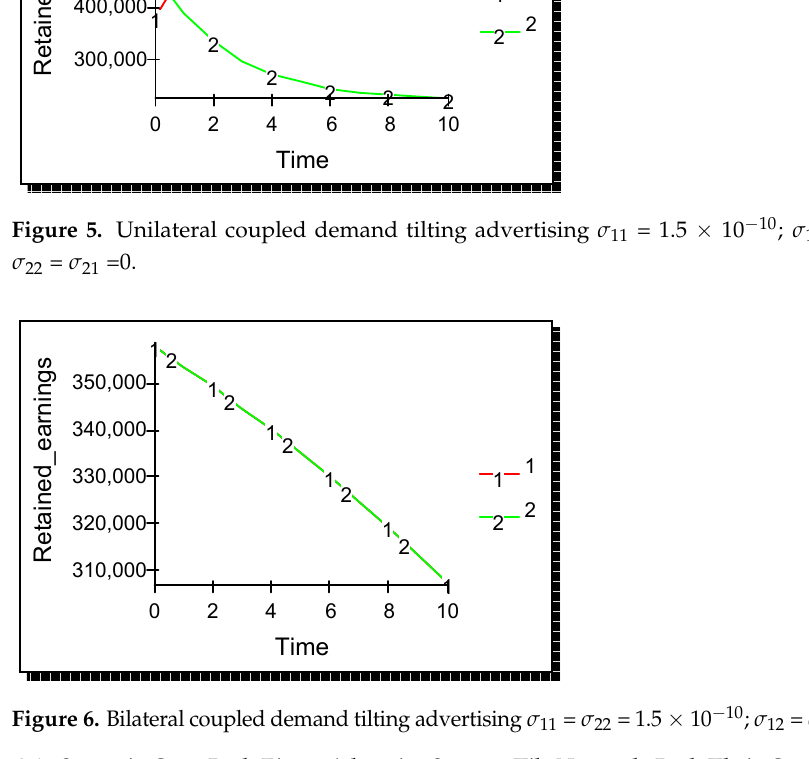
Figure 6. Bilateral coupled demand tilting advertising σ 11 = σ 22 = 1.5 × 10 − 10 ; σ 12 = σ 21 = − 1.5 × 10 − 10 .